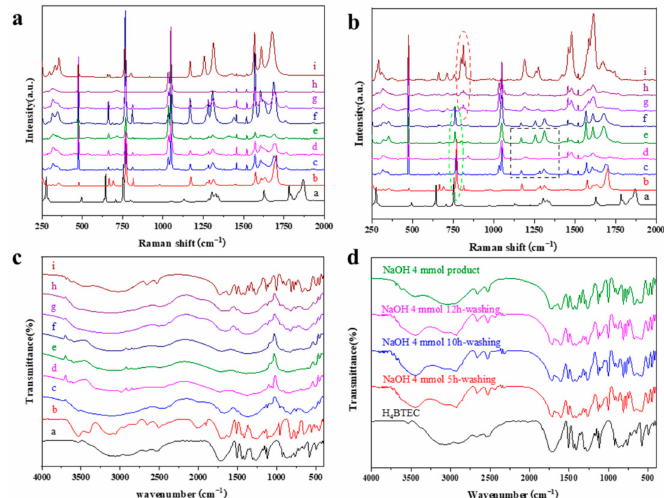
Figure 5. ( a ) Raman spectra of group A without NaOH. a, H 4 BTEC; b, pyromellitic acid